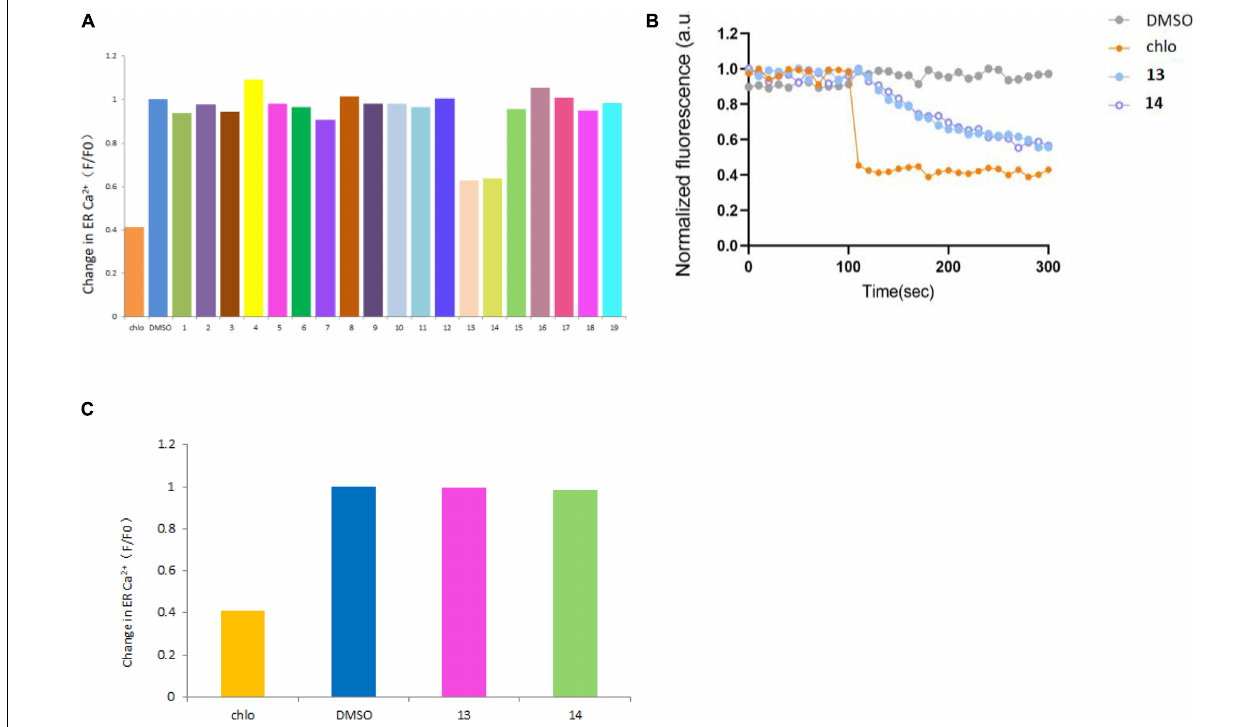
FIGURE 6 | Summary of against activities of compounds 1 – 19 on sfRyR (A) and compounds 13 and 14 on rRyR1 (C) at 100 µ M; Time-lapse R-CEPIA1er fluorescence measurement curves of 13 and 14 (B) with chlorantraniliprole (chlo) and DMSO as positive and negative controls, respectively.